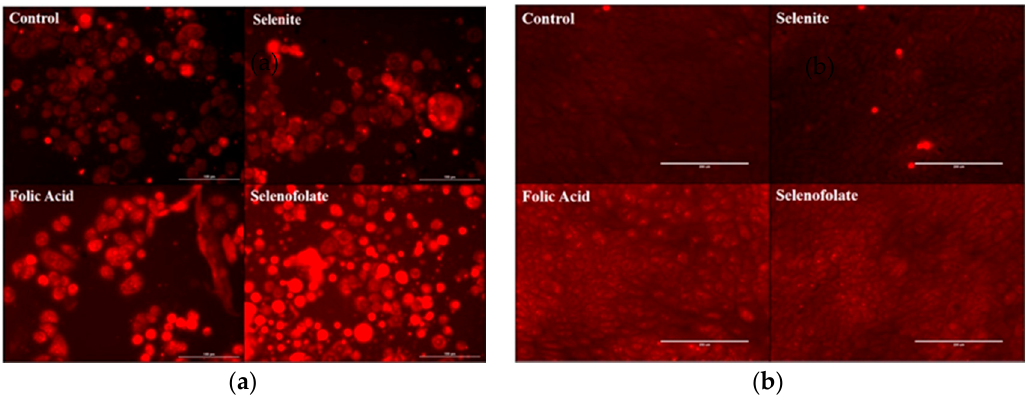
Figure 9. Photomicrographs of intracellular superoxide generation by Dihydroethidium (DHE) red florescence. ( a ) MDA-MB-468 Cells (left panels) with scale bar at 100 µm. ( b ) HME50-5E cells (right panels) with scale bar at 200 µm. Results were photographed after 30 min of treatment with untreated control, 20 µM selenite (10 µg Se), 100 µM Folic Acid and 100 µM Selenofolate (8 µg Se).